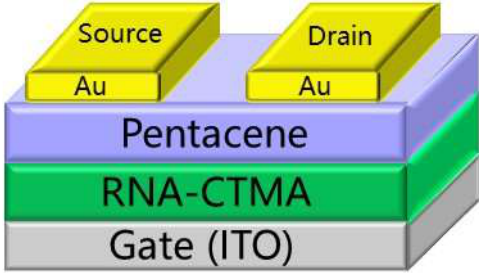
Figure 1. Schematic representations of the BioTFT memory using RNA–CTMA (cetyltrimethylammonium) as the gate dielectric layer.